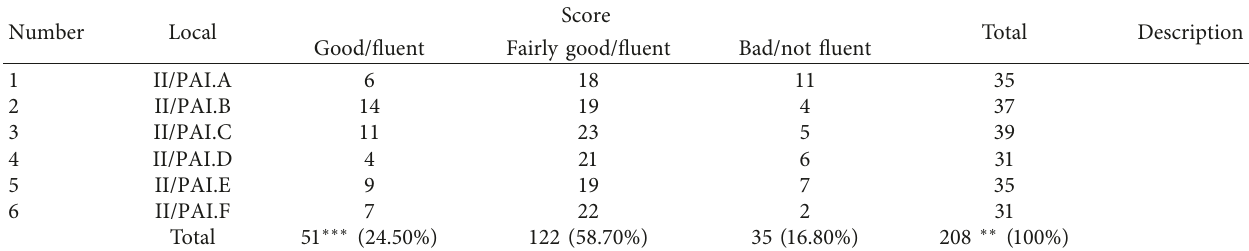
Table 1: Assessment of Quranic reading skills of 2 nd semester students in 2016–2017 ∗ .